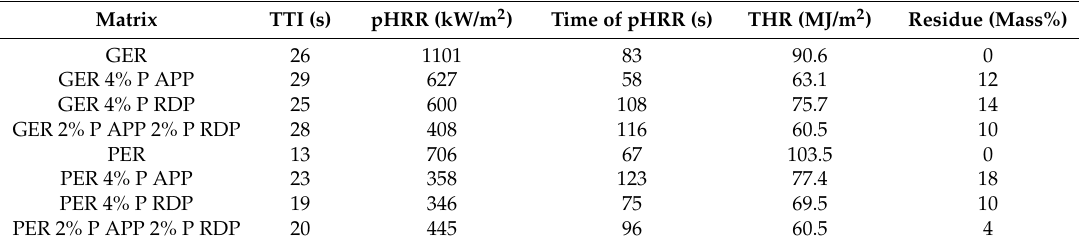
Table 5. Mass loss calorimetry (MLC) results of the reference and flame retarded PER and GER